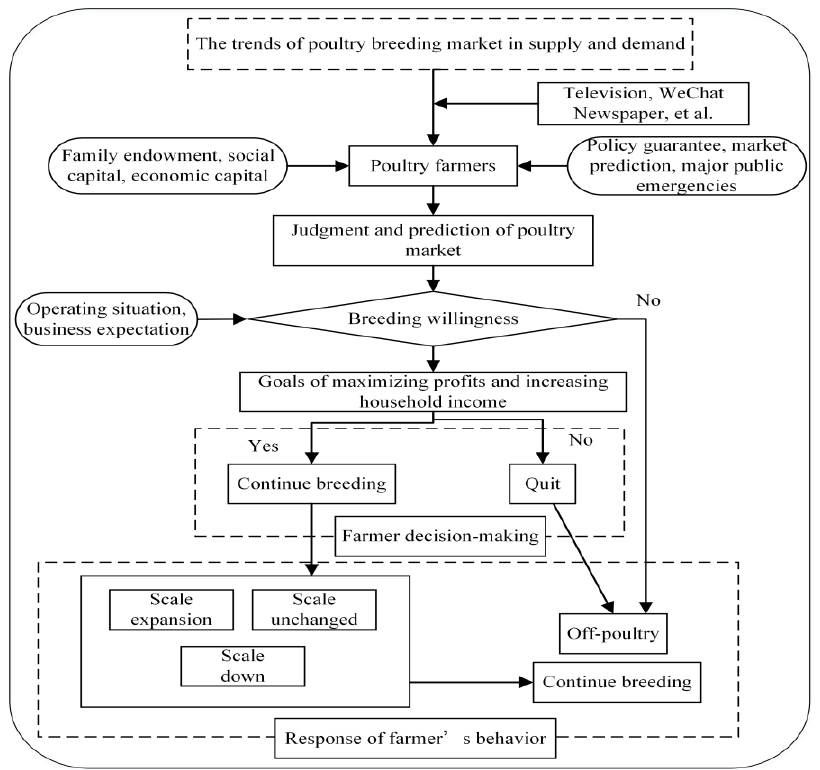
Figure 1. Mechanism framework of poultry farmers’ willingness and behavior .